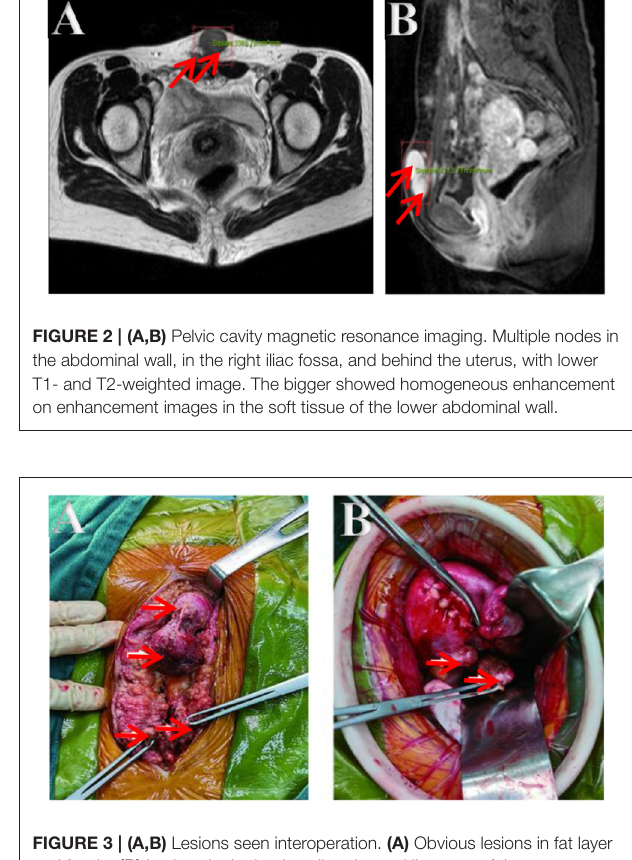
very easy to be misdiagnosed and missed before operation.